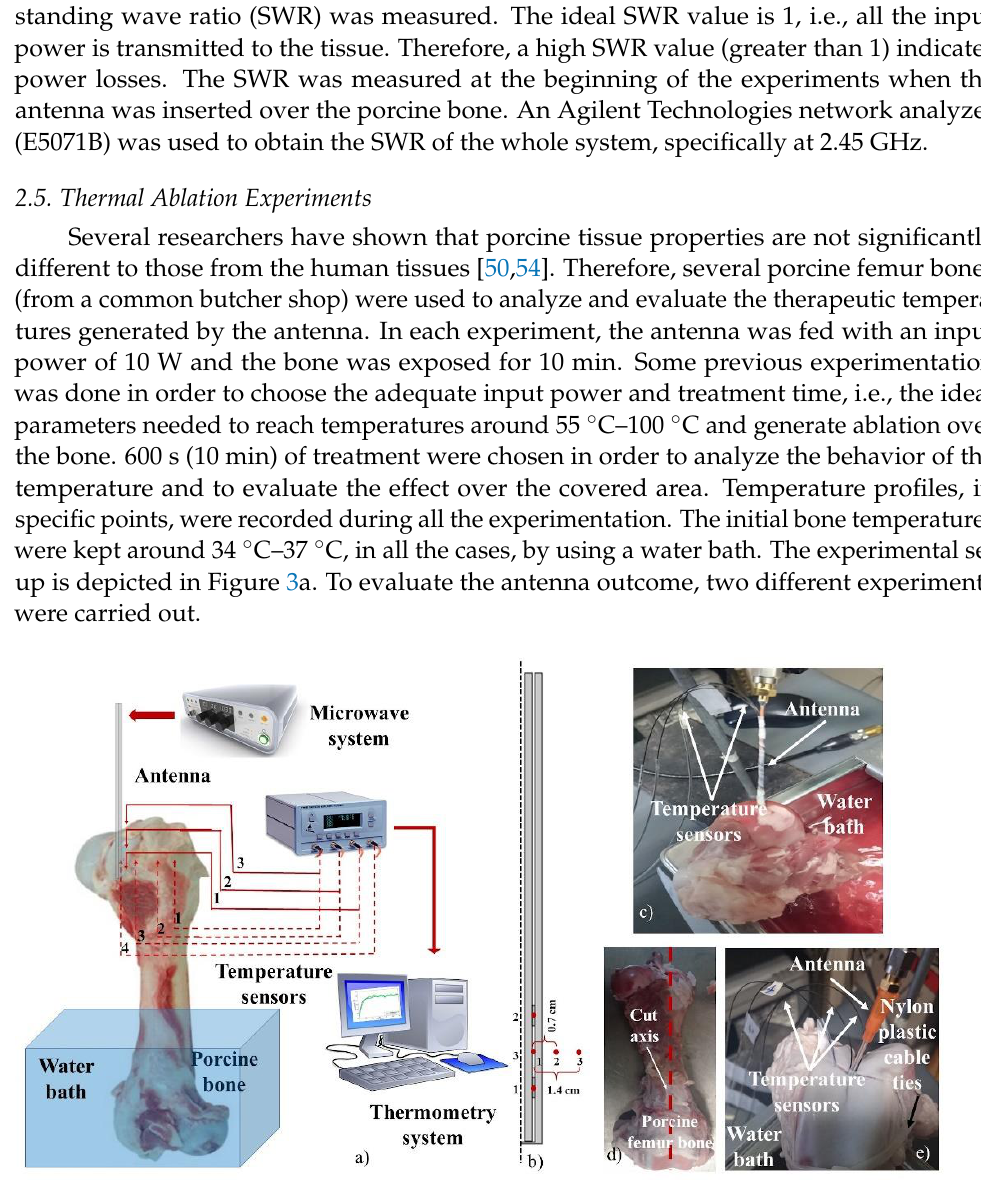
Figure 3. Experimental set up used to make the antenna evaluation in a porcine bone (femur). ( a ) equipment used in the experimental evaluation; ( b ) location of temperature sensors used in the antenna evaluation; ( c ) set up used for the antenna insertion evaluation; ( d ) incision of the porcine bone tissue; ( e ) set up for the thermal distribution evaluation.